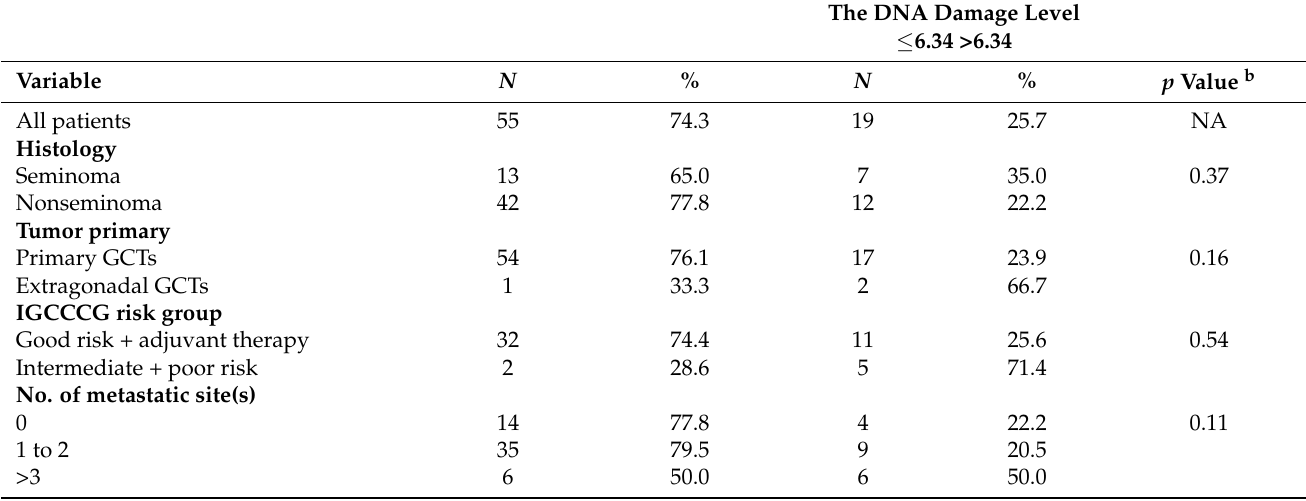
Table 2. Association between the endogenous DNA damage level and patients’ clinicopathological characteristics using univariate statistical analysis ( N = 74; a cutoff value of 6.34 was used for dichotomization of endogenous DNA damage level measured in the patients’